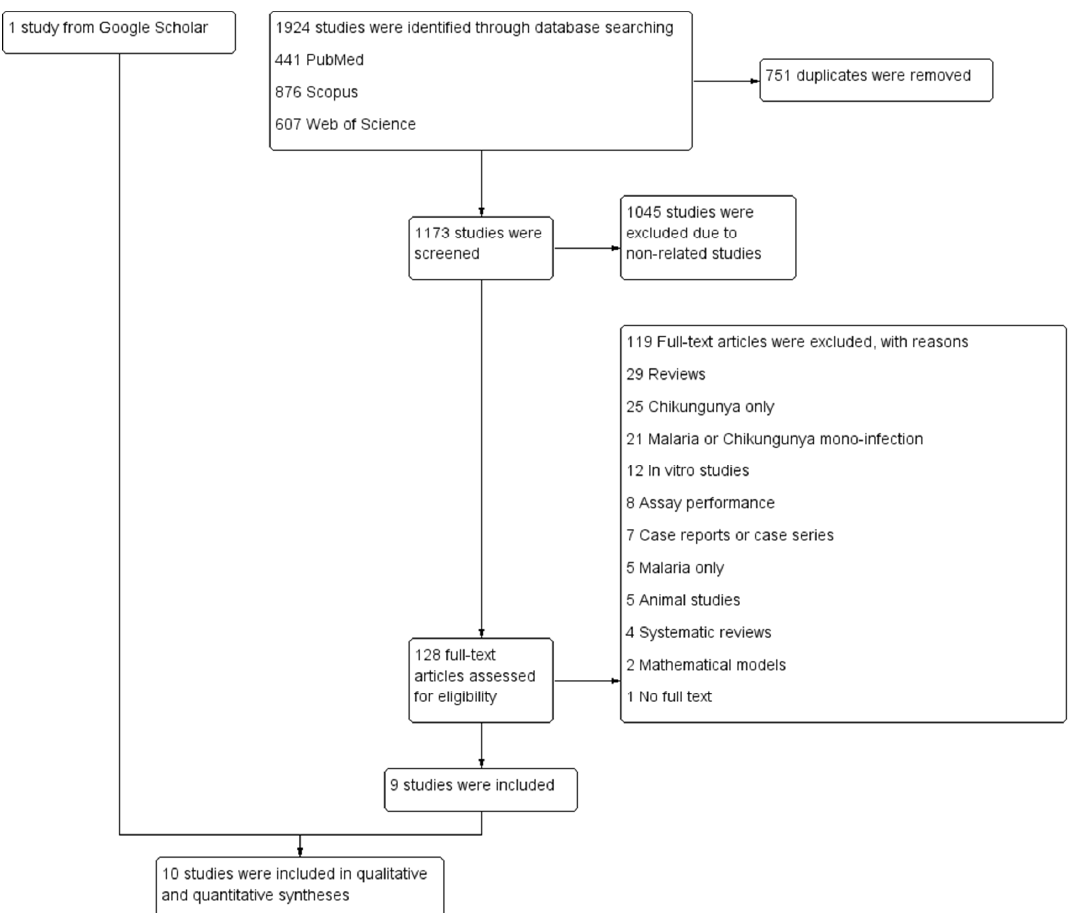
Figure 1. Study flow diagram.